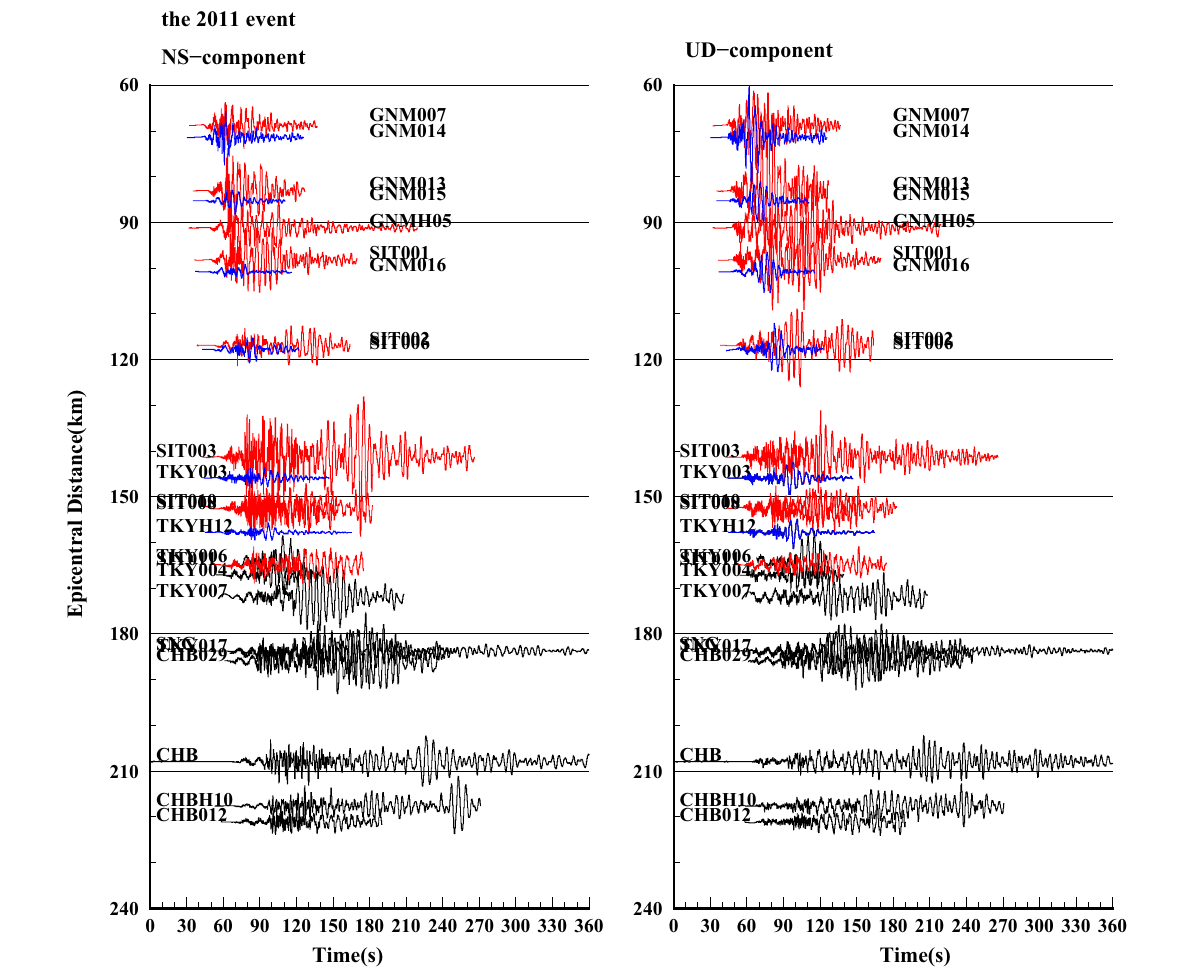
Fig. 11 Sections of velocity seismograms observed during the 2011 event. The left-side figure shows the traces in the NS component. The right-side figure shows the traces in the UD component. Red traces are observed at stations on the deep trench of the Kanto Basin, as shown in Fig. 2. Blue traces indicate the ground motions at stations located outside the basin, as shown in Fig. 2. Black traces indicate the stations used in Fig.